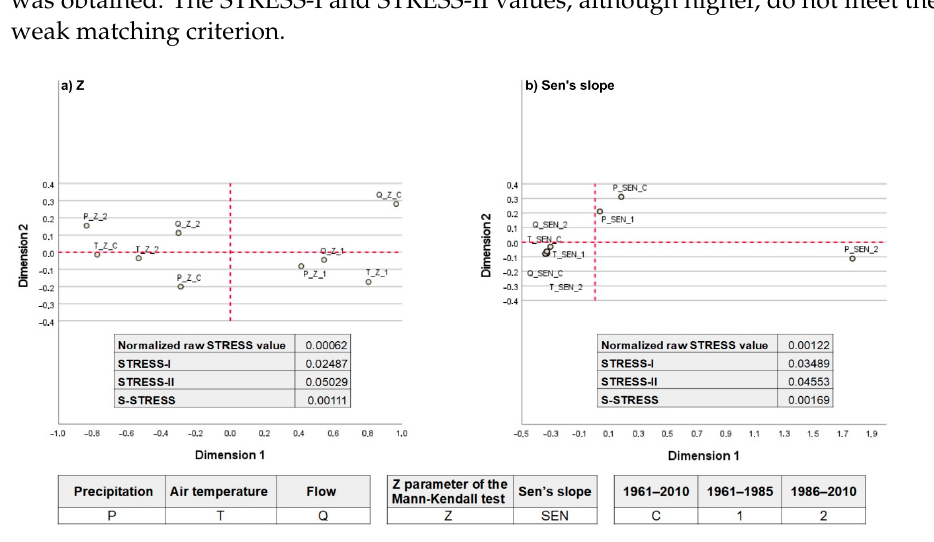
Figure 5. Results of multidimensional scaling: ( a ) for Z parameter of the Mann-Kendall test; ( b ) for Sen’s slope